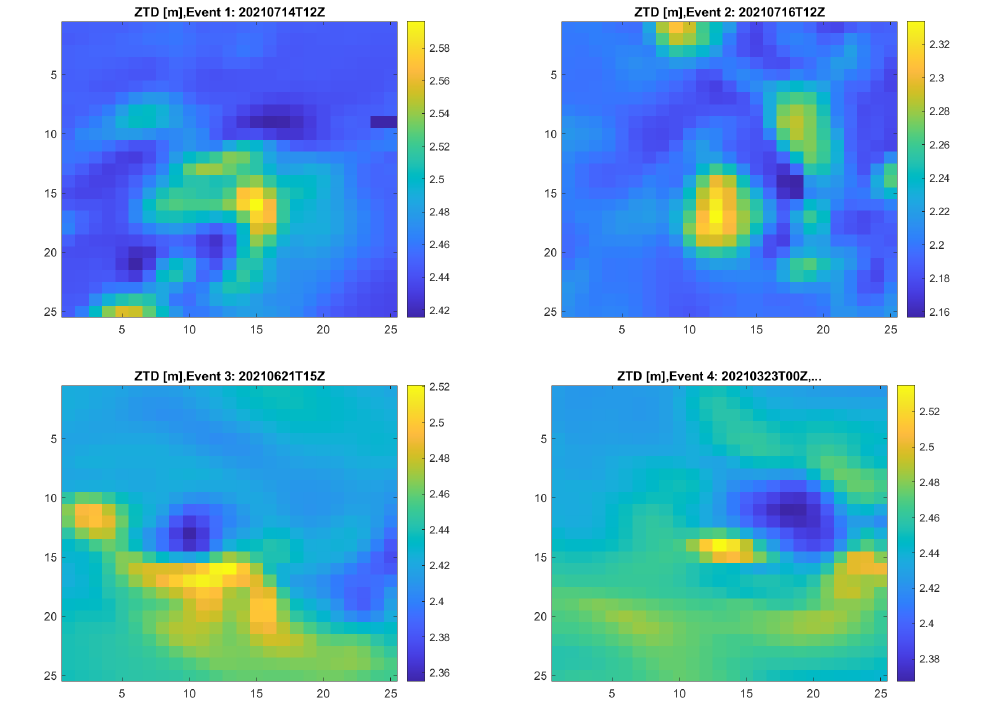
Figure 7. ZTD values for the four largest